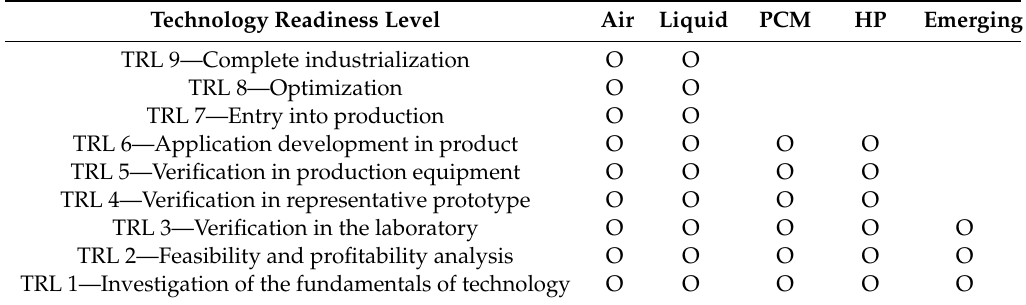
Table 1. Technology readiness level (TRL) of battery thermal management system (BTMS) in